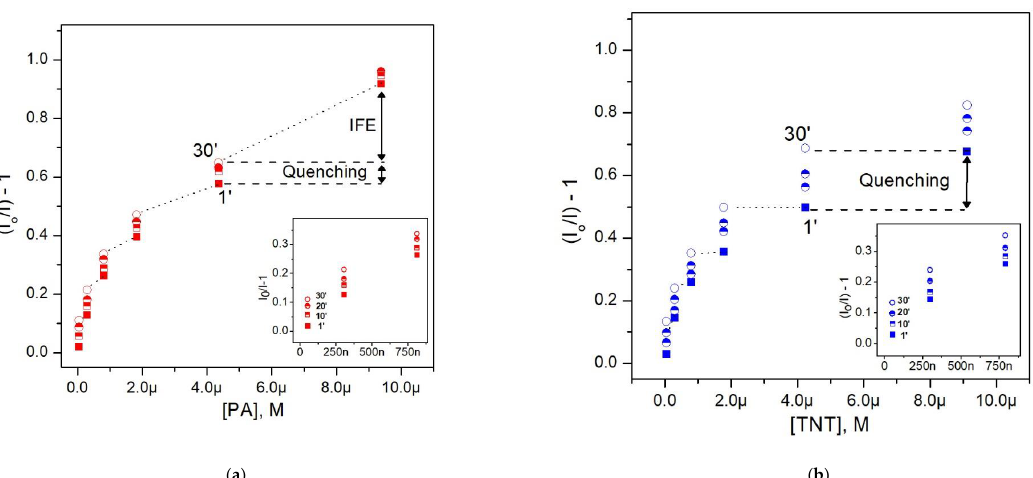
Figure 7. The Stern–Volmer plots for PN26 films ( λ exc = 361 nm, λ obs = 500 nm) with ( a ) picric acid (PA) and ( b ) trinitrotoluene (TNT). Dotted lines are guides to the eye. Dotted lines join the last measurement (after 30 min) at a given concentration and the first (after 1 min) at the next concentration. Insets in the graphs show an expansion of the scale close to the